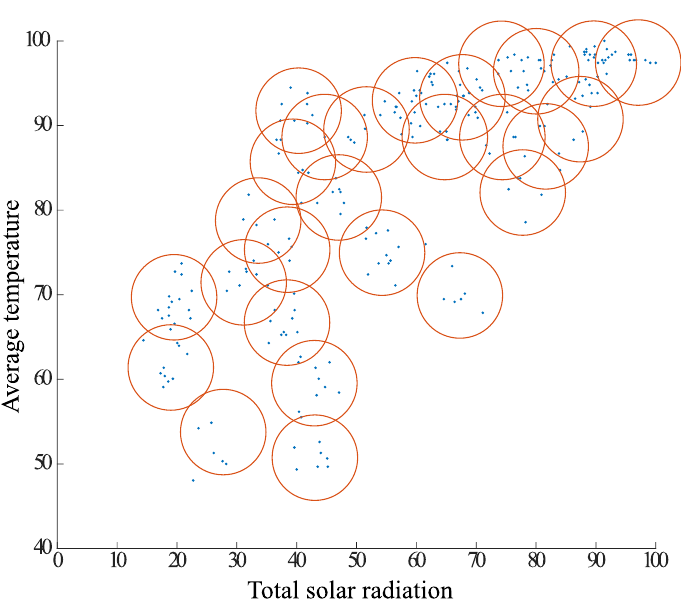
Figure 18. Step 8